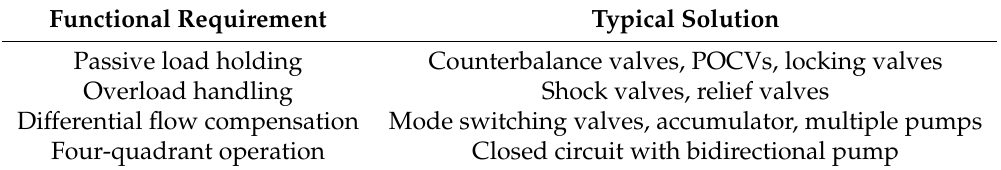
Table 1. Requirements for the